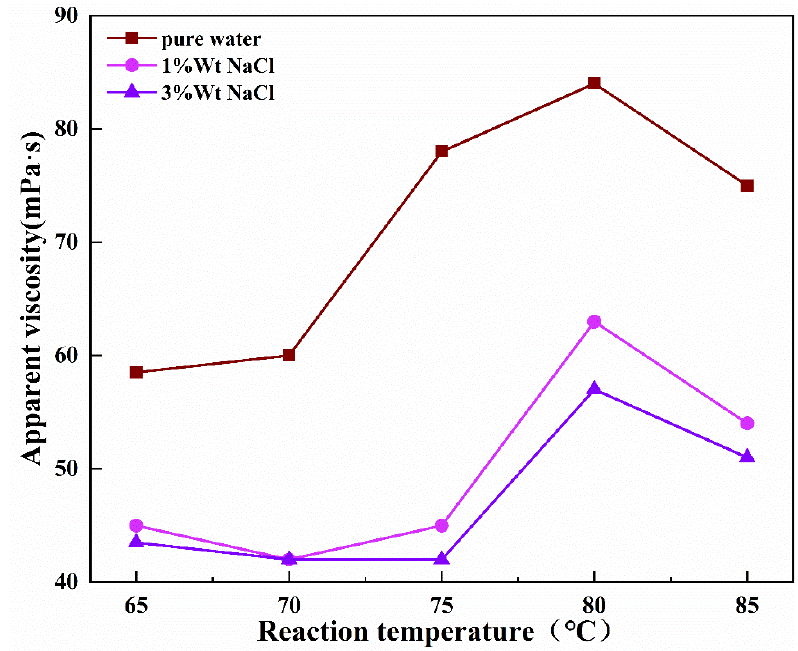
Figure 3. Influence of reaction temperature on viscosity.